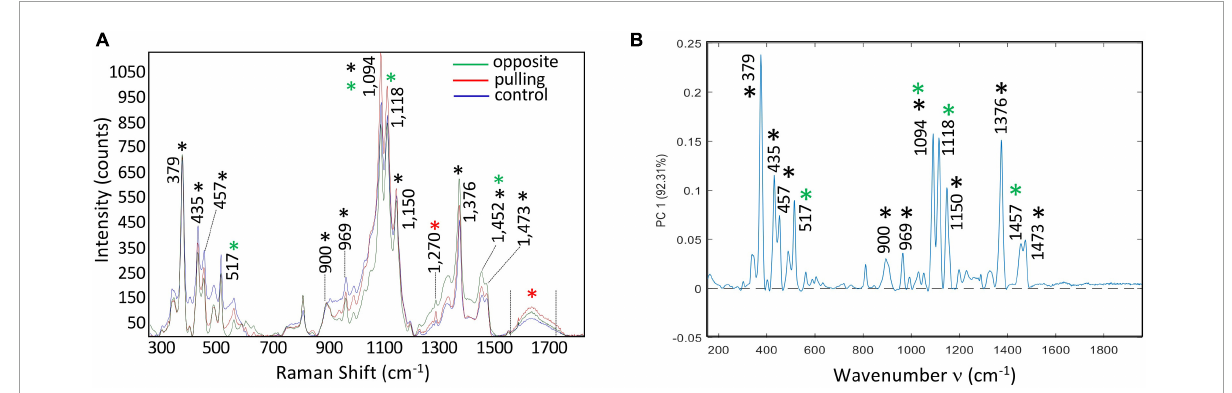
FIGURE2 (A) Average spectra of bast fibers from control conditions (blue), and stressed conditions: pulling side (red) and opposite side (green). Acquisition was performed in the plant cell wall fingerprint range (300: 1,800 cm − 1 ). Spectra were treated for the baseline, then aligned on the cellulose band (379 cm − 1 ). Main chemical bonds were assigned to cell wall polymers (Black asterisk: cellulose, Red asterisk: lignin, Green asterisk: xylan and xyloglucan). (B) PC1 (92.31%) loading vector. Bands were assigned to cell wall polymers: Black asterisk: cellulose, Red asterisk: lignin, Green asterisk: xylan and xyloglucan.